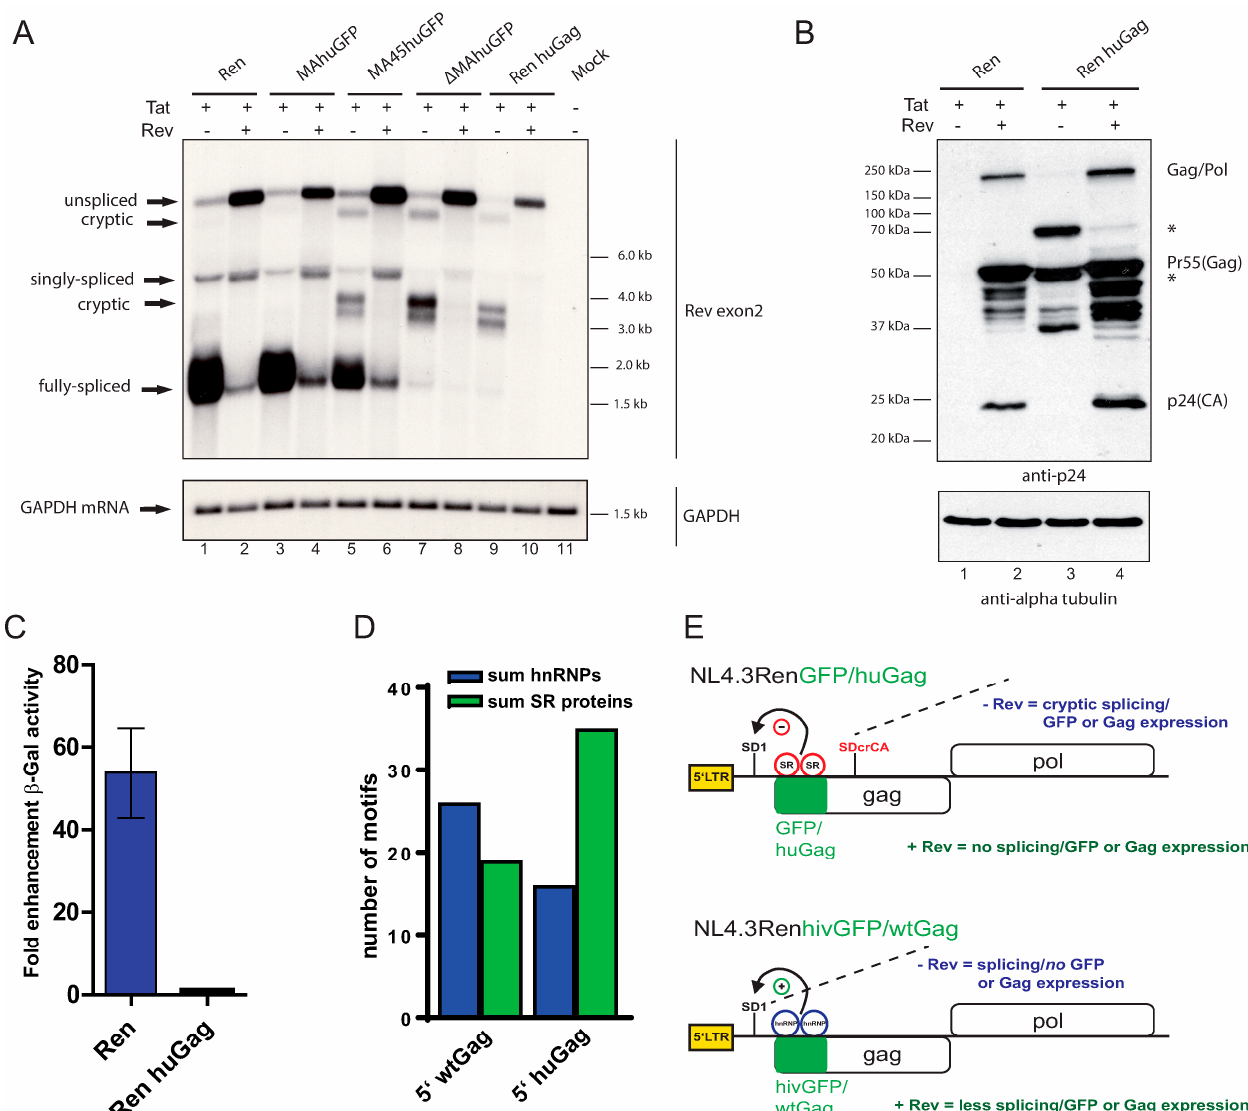
Figure 4. Humanizing 5 ′ HIV gag sequences yields the identical phenotype as a huGFP insertion. ( A ) Northern blot of total RNA from HEK 293T cells transfected with the indicated proviral constructs with huGFP insertions compared to the splicing pattern of a construct with a humanized 5 ′ HIV gag sequence (Ren huGag). Membranes were hybridized with a probe specific for Rev exon 2 and rehybridized with a GAPDH probe (both indicated on the right), which served as the loading control. The different splice variants are indicated on the left and the RNA sizes on the right. ( B ) Western blot using protein extracts from the indicated co-transfections. Detection was performed with an anti-p24 antibody. Alpha tubulin served as a loading control. The newly detected Gag protein isoforms are marked with an asterisk. A size marker in kDa is indicated on the left. The asterisks mark unknown Gag isoforms. ( C ) Titer analysis using supernatants containing VSV-G pseudotyped wildtype Ren- or Ren huGag-derived particles. A p24 ELISA was used to adjust the supernatants before titration on HeLa P4 cells containing integrated β -galactosidase under the control of an HIV-1 long terminal repeat. Data from three independent experiments with supernatants from two different harvesting time points per experiment are shown ( n = 6). Error bars represent SD. ( D ) Analysis of putative binding motifs for hnRNP or SR proteins by RBPmap (http://rbpmap.technion.ac.il/ (accessed on 05/25/2021)). The first 700 nts of either wild type HIV gag or the humanized version were analyzed. ( E ) Model depicting the influence of the mRNP code on the activity of the major SD1. In the case of huGFP or the humanized Gag sequence, SR proteins preferentially bind and suppress SD1, leading to activation of the cryptic SD (SDcrCA, in red). In the case of the HIV-like GFP or the wild type Gag sequence, hnRNPs are recruited that activate the SD1.